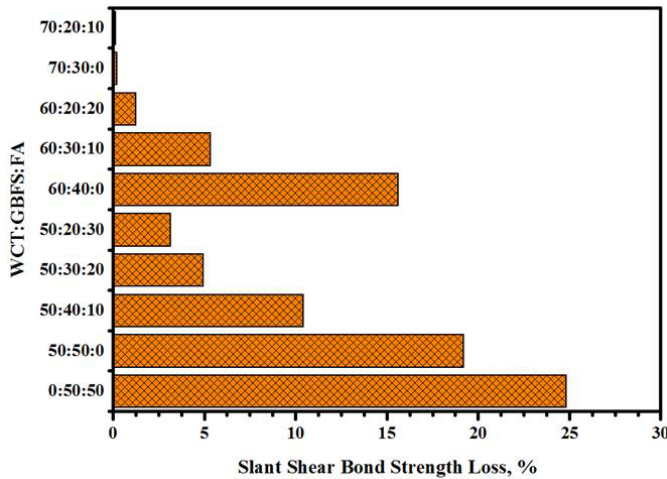
Figure 5. Effect of H 2 SO 4 solution on SSBS performance of GPMs.